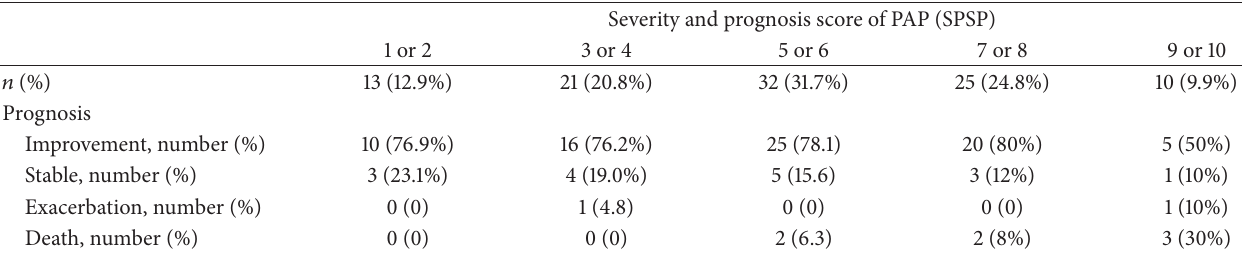
Table 9: Prognosis of patients according to SPSP. Severity and prognosis score of PAP